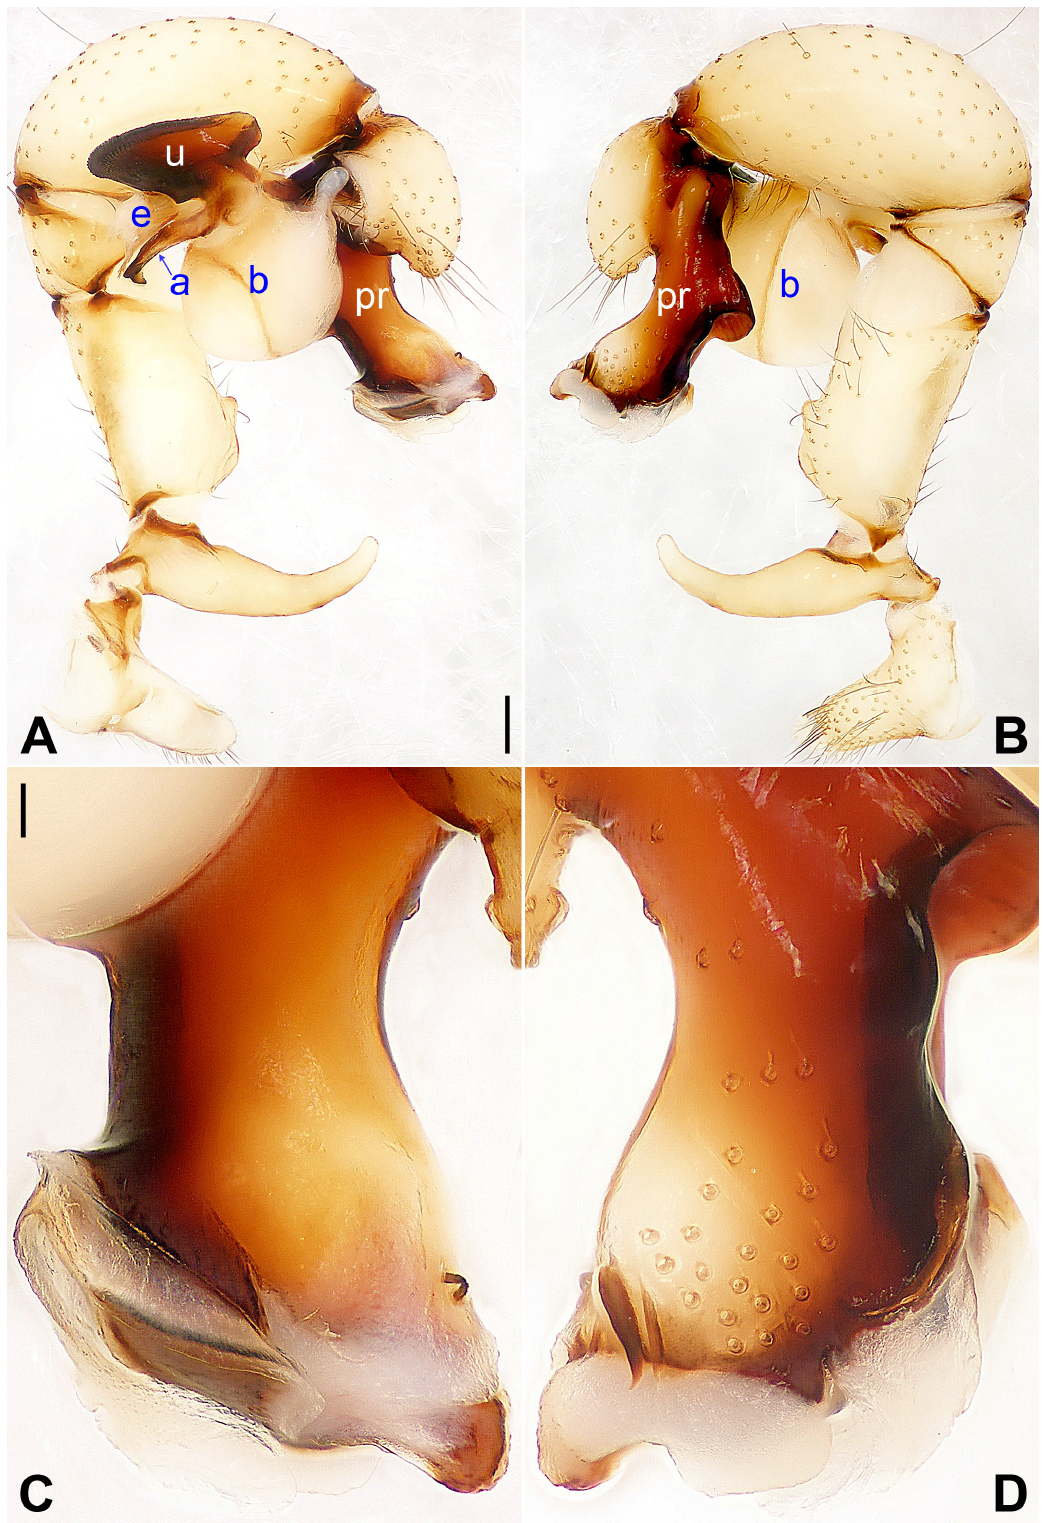
Fig. 5. Pholcus sidorenkoi Dunin, 1994, ♂. A–B . Pedipalp (A. Prolateral view. B. Retrolateral view). C–D . Distal part of procursus (C. Prolateral view. D. Retrolateral view). Abbreviations: a = appendix; b = bulb; e = embolus; pr = procursus; u = uncus. Scale bars: A–B = 0.20 mm; C–D = 0.05